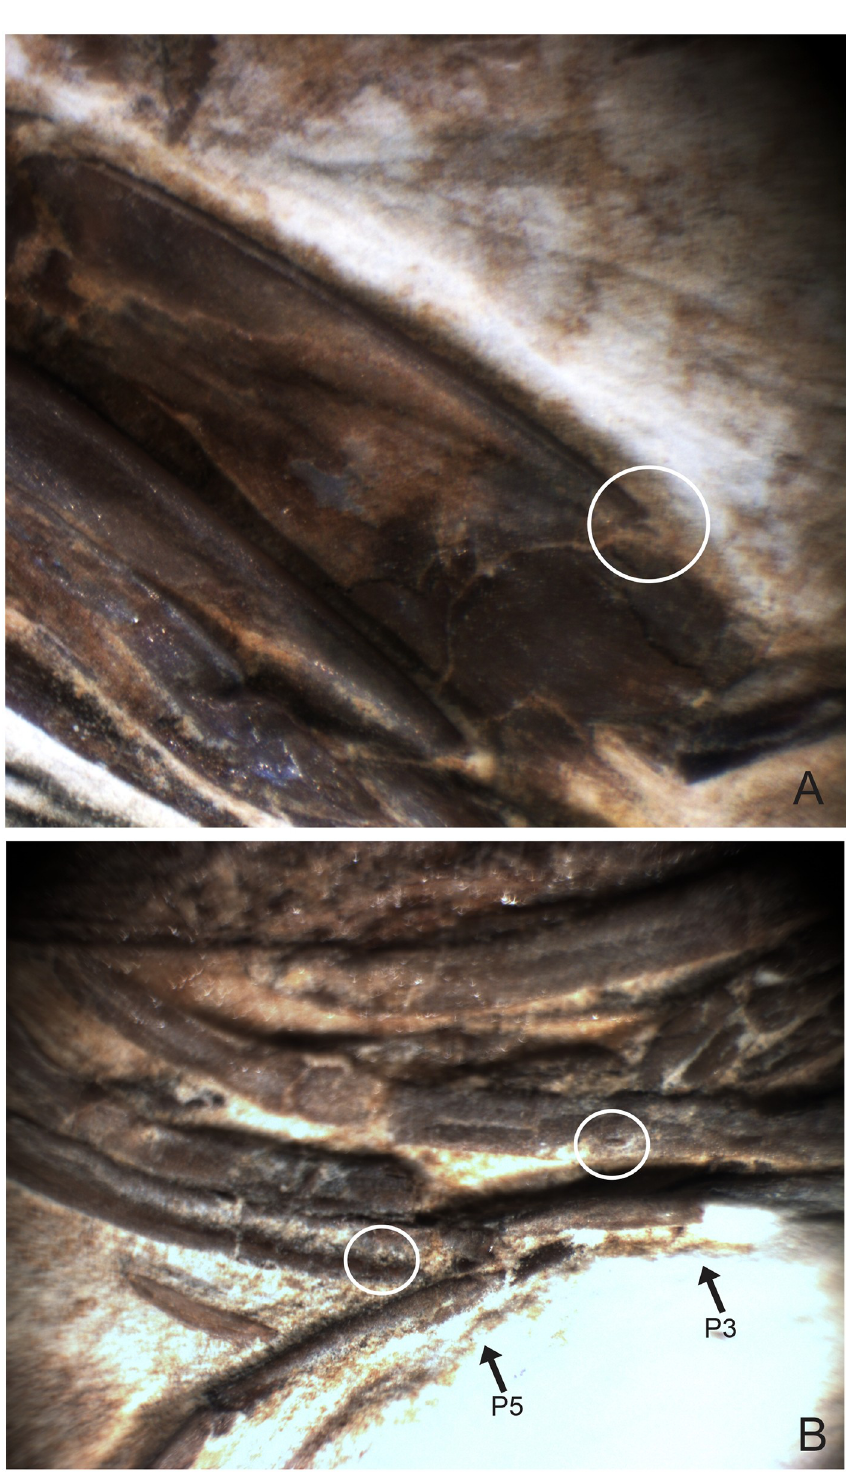
Fig 4. 2466/CRT (UFC). (A) Detail of the uropod. Exopodite with diaresis has crossed by a thin longitudinal carina running parallel to the outside lateral margin and ending with a small spine in highlighted. The endopodite without ornamentation. (B) Detail of the Pereiopods with